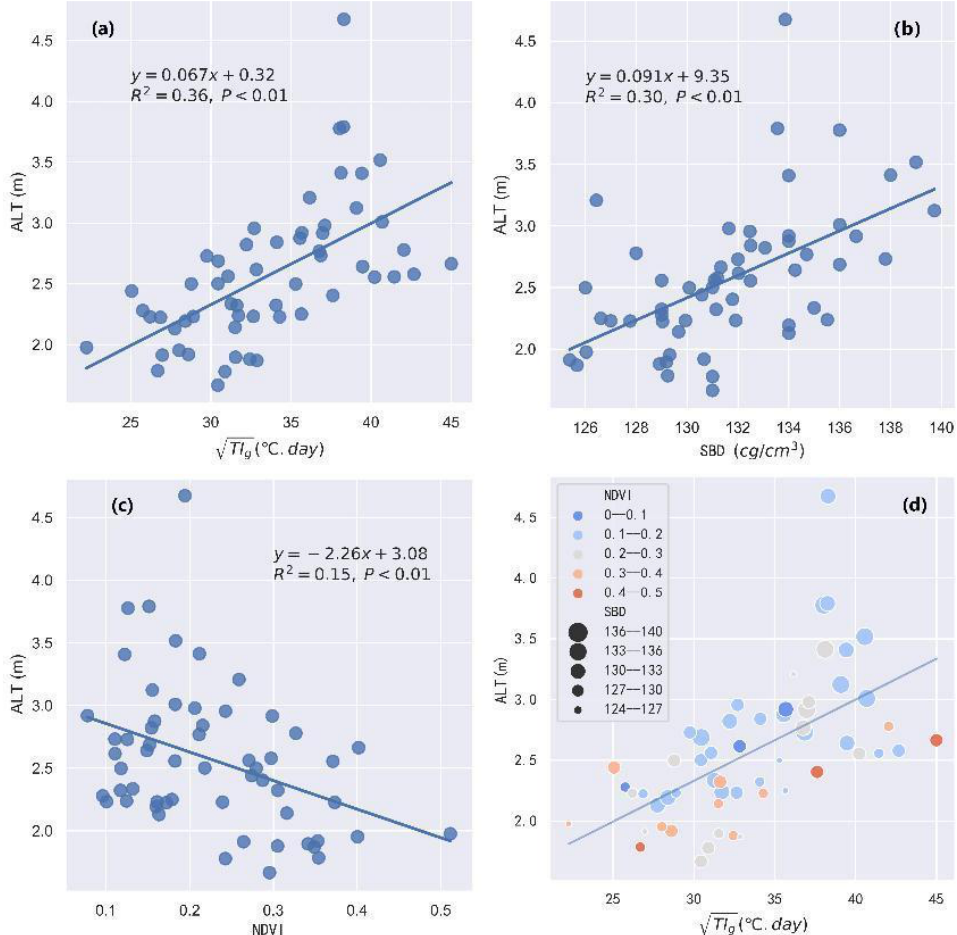
Figure 9. Relationship between active layer thickness (ALT) and the controlling factors of ( a ) the (cid:112) TI ground thawing index ( g ), ( b ) soil bulk density (SBD), ( c ) normalized difference vegetation index ground thawing index ( g TI ), ( b ) soil bulk density (SBD), ( c ) normalized difference vegetation (NDVI), and ( d ) the combined topoclimatic index (NDVI), and ( d ) the combined topoclimatic influences.